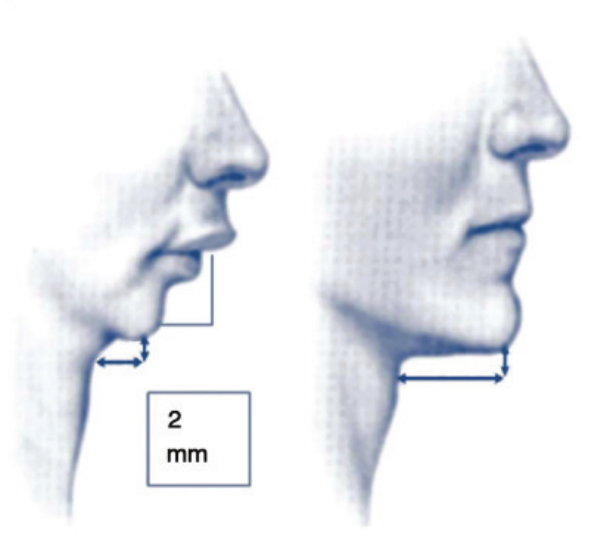
Figure 1 Retrognathia.